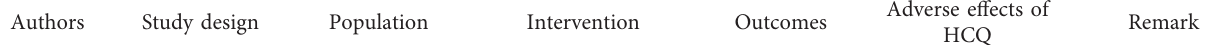
Table 2: Characteristics of the studies included in the